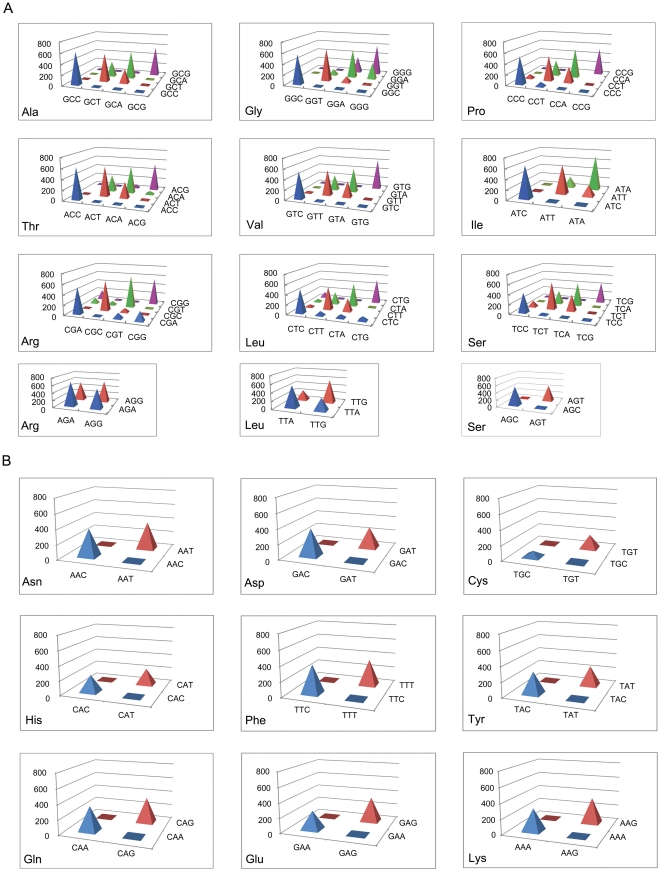
3D-pyramid distribution chart showing the variation of overrepresented codon pairs within different codon families.The vertical axis represents the total number of bacterial genomes in which a given synonymous codon pair is overused. A total of 773 bacterial genomes were analyzed. A: Distribution of overrepresented codon pairs in three-fold, four-fold, and six-fold degenerate codon families. The three examples of six-fold codon families were regarded as combined four-fold and two-fold codon families. B: The distribution of overrepresented codon pairs in two-fold degenerate codon families.